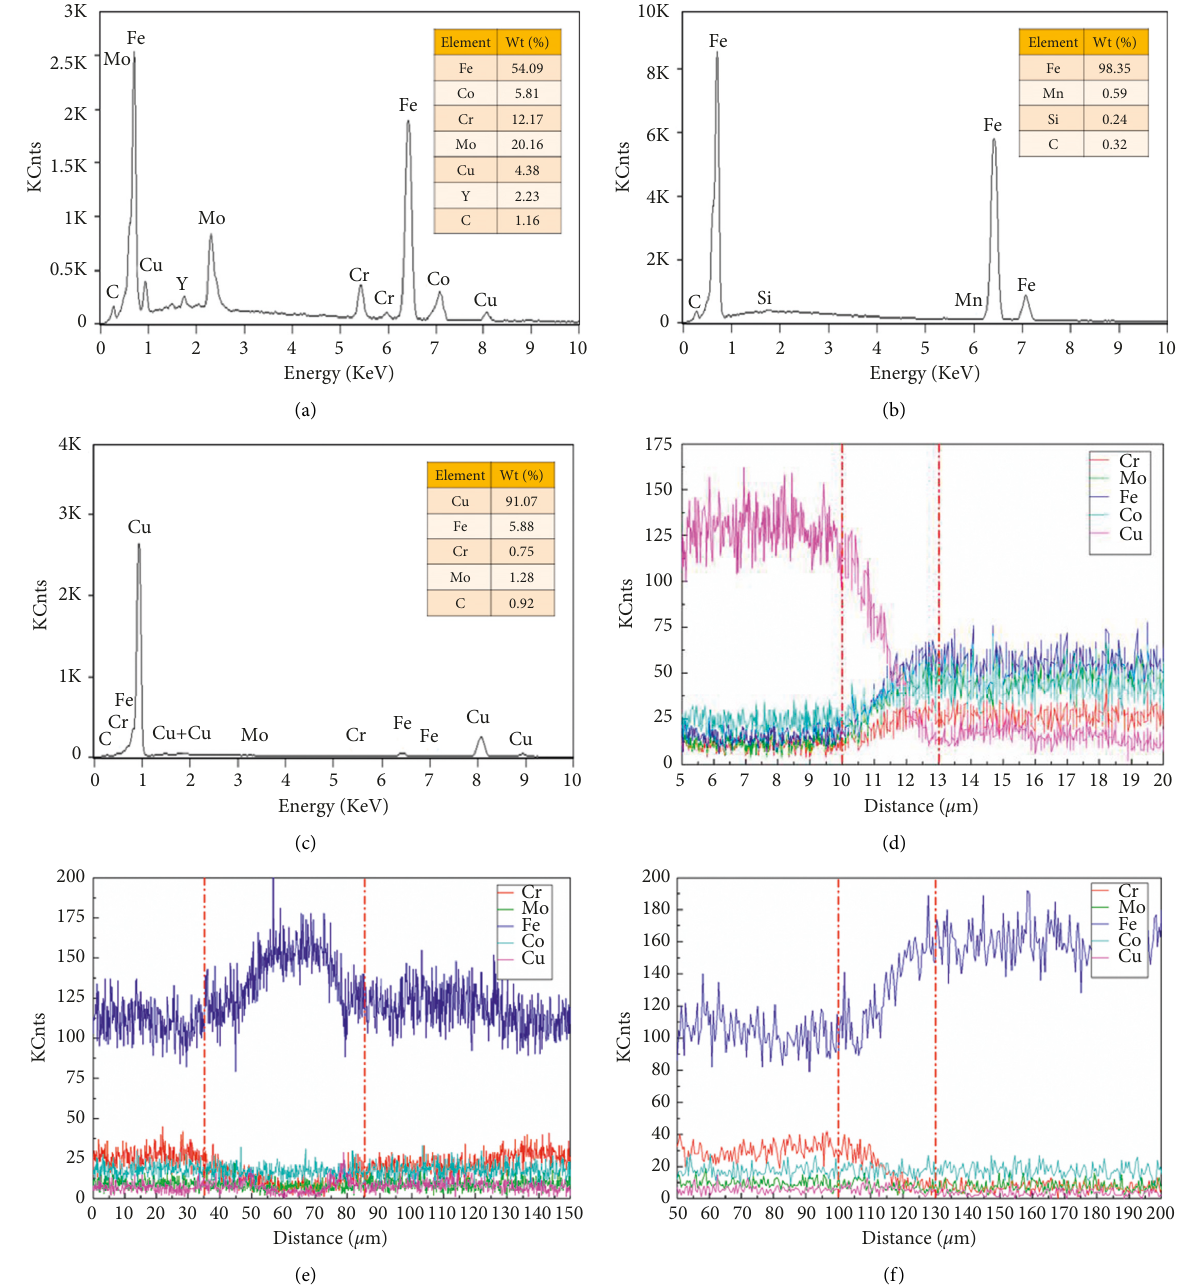
Figure 4: EPMA spot scanning result: (a) grey-white phase; (b) black phase; (c) golden phase. The EPMA linear scanning result: (d) interface between grey-white phase and golden phase; (e) across black phase; (f) interface between coating and